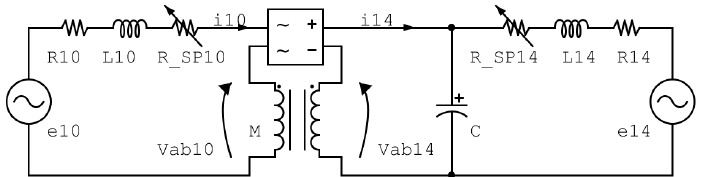
Figure 9. Rotor winding connections at direct rotation: 10th harmonic power supply and 14th harmonic excitation field.